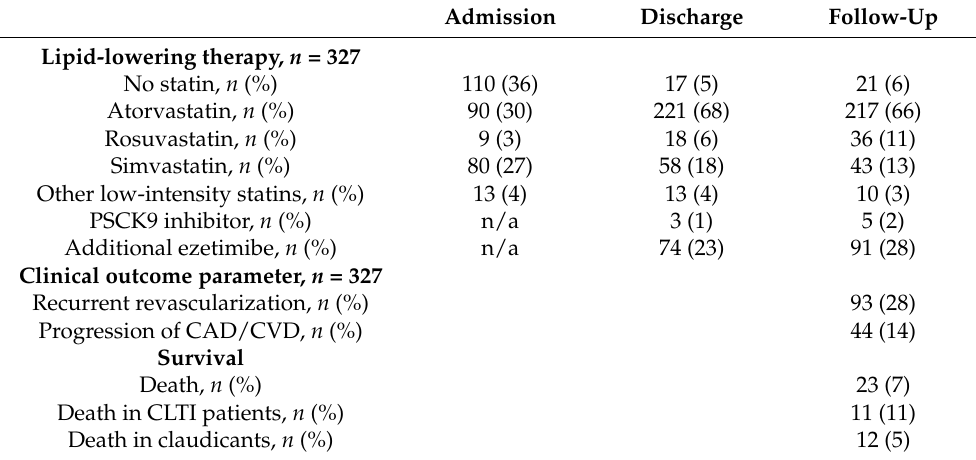
Table 3. Follow-up data on lipid-lowering therapy and clinical